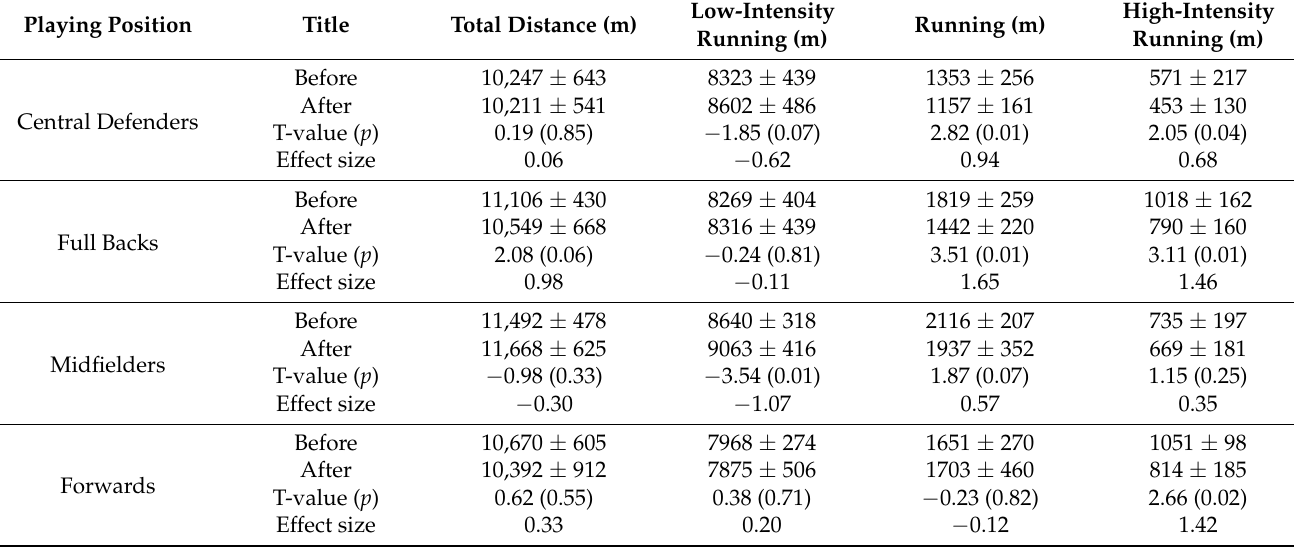
Table 1. Descriptive statistics and differences in total distance, low-intensity running, running, and high-intensity running before and after lockdown in Croatia.